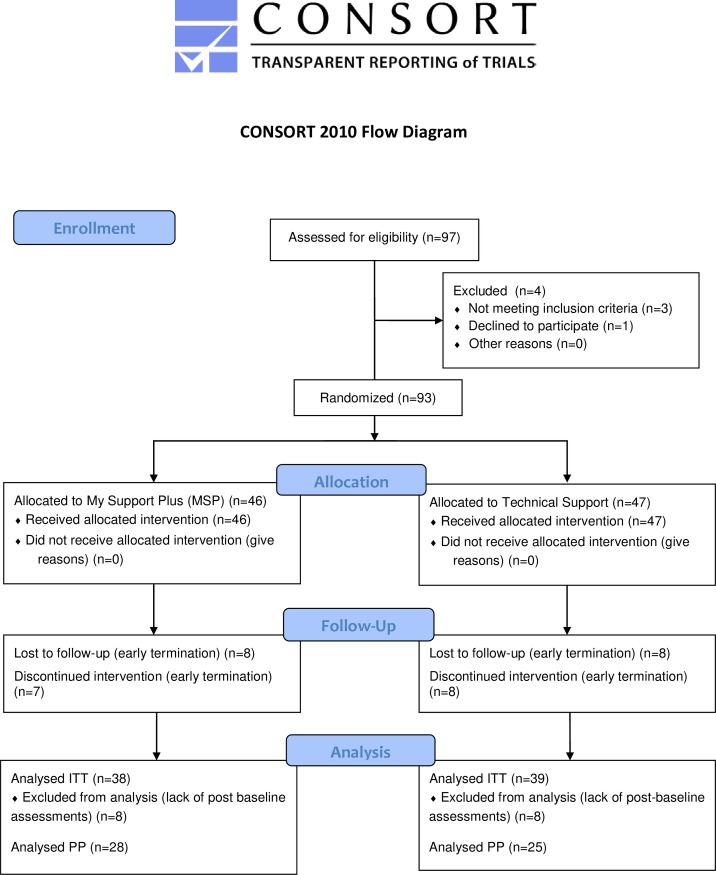
Patient flow.The outline of the selection and randomization flow of patients in the study. Intent to treat (ITT), Per protocol (PP).